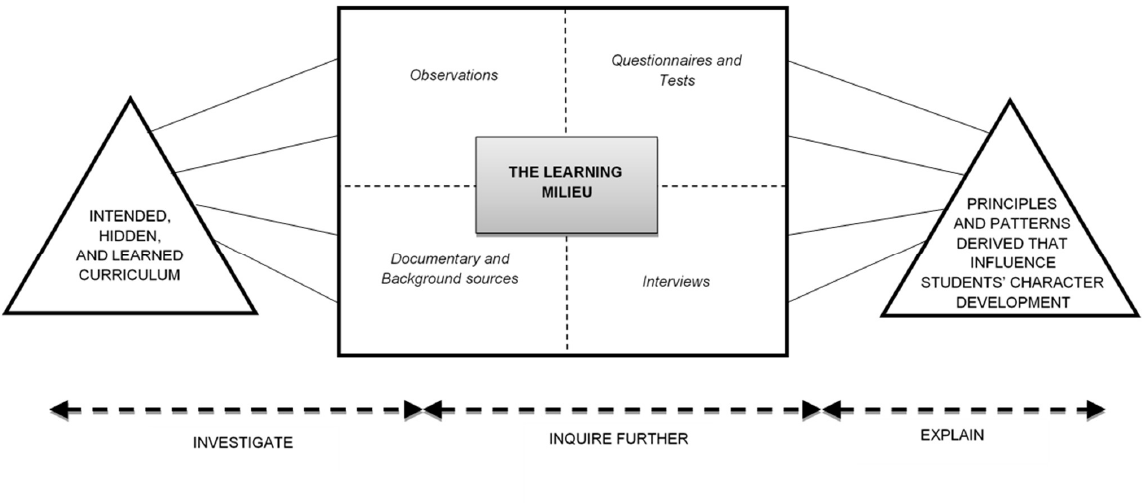
Figure 1. The Illuminative Evaluation Model as derived from the Explication